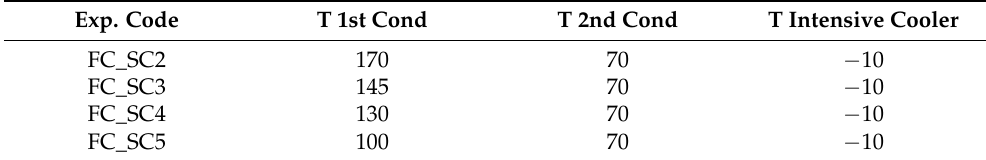
Table 3. Temperature settings for the condensation system, expressed in ◦